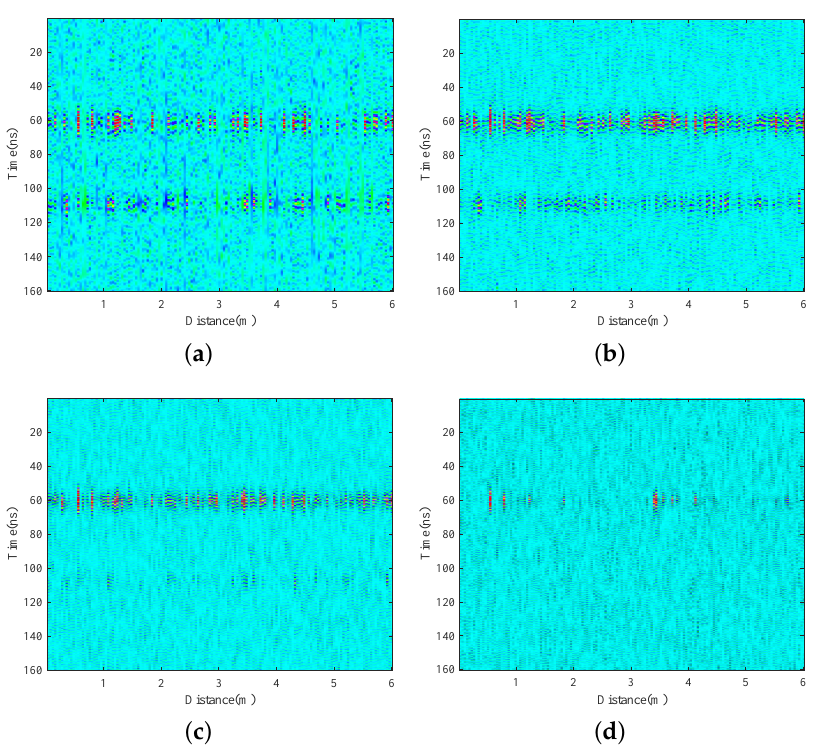
Figure 15. The IMFs obtained by WOA-VMD-BD of the simulated data in HV polarization